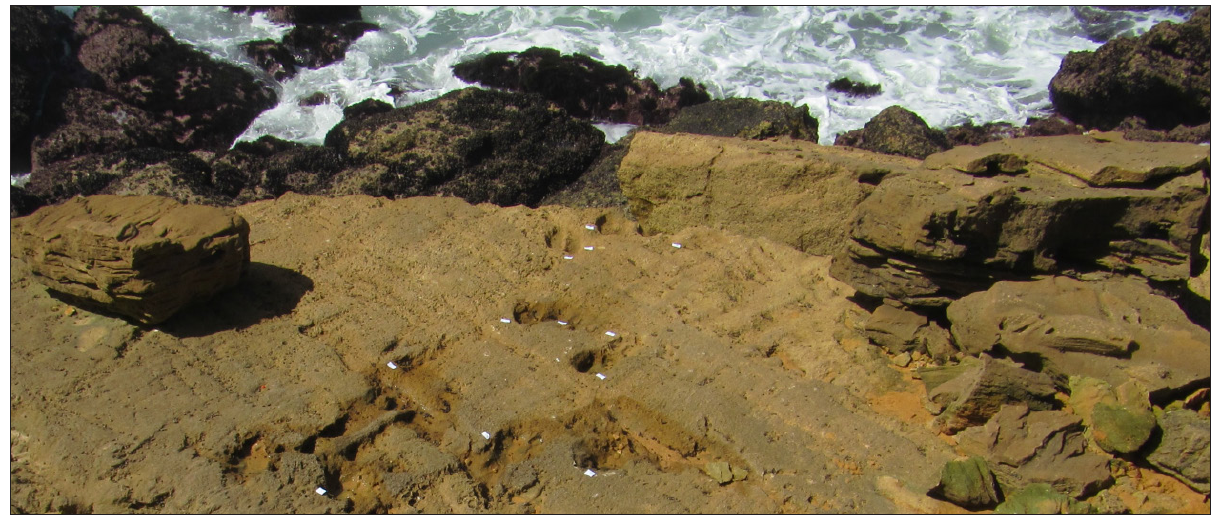
Figure 3: Giraffe tracks on rock surface perched above the Indian